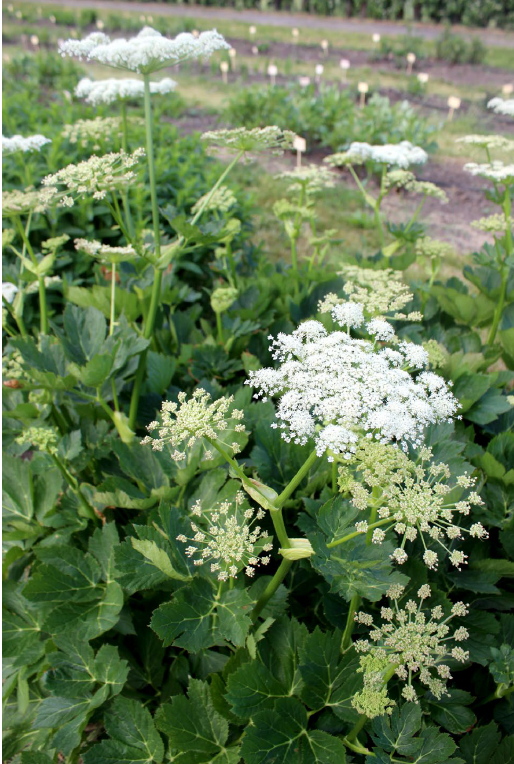
Figure 4. Peucedanum ostruthium ‘Kobota’. One of the samples of masterwort collected, evaluated and described in Swedish nationwide inventories of cultivated plants (Photo: Erik de Vahl).